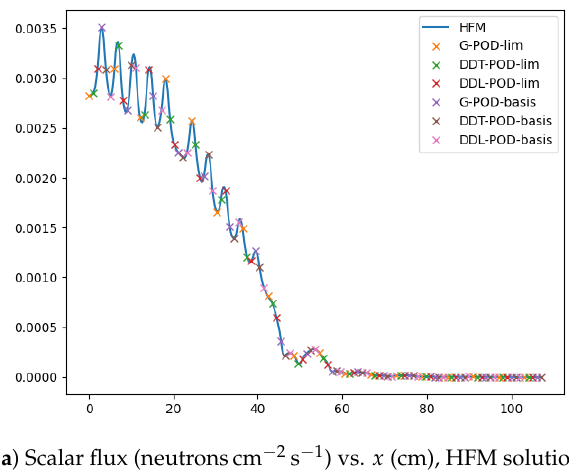
for all POD-based ROMs, with the limited number of snap- shots or smart selection of the number of basis functions, in crosses.